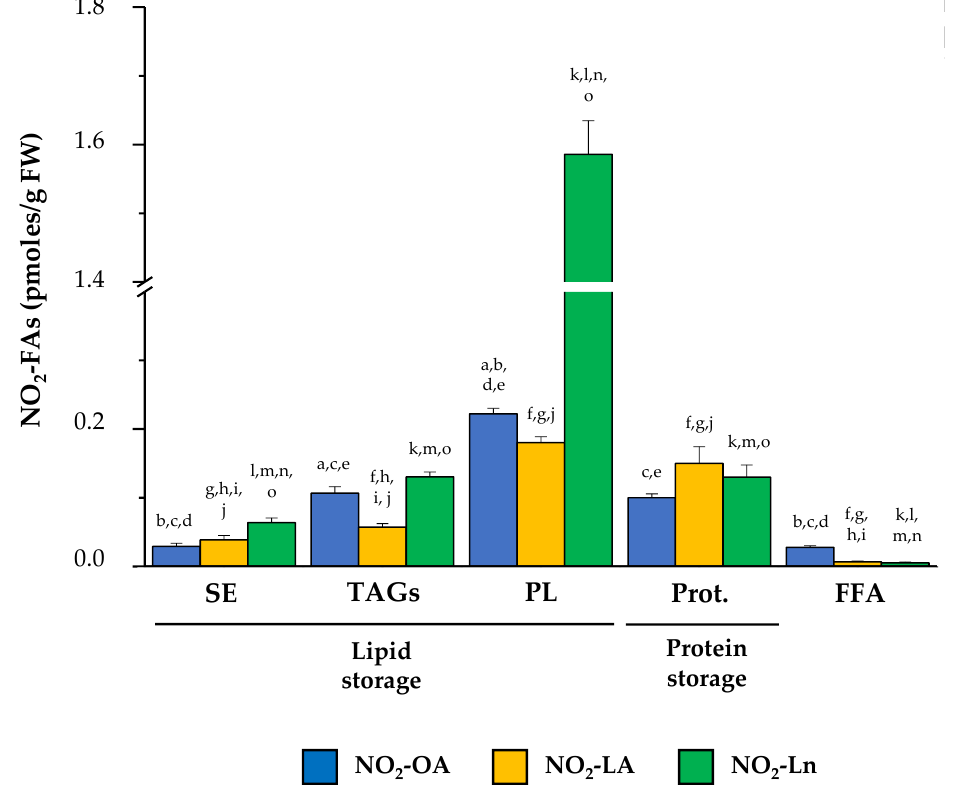
Figure 3. The main NO 2 -FAs storage biomolecules in Arabidopsis thaliana . This figure shows the different lipid and protein reservoirs of NO 2 -FAs in the 14-day-old Arabidopsis seedlings. The lipid deposit consisted of SE, TAGs (including MAGs-DAGs), and the four phospholipid types (PC, PE, PS, and PI). The protein deposit is represented by the NO 2 -FAs that were experimentally released from adducts with proteins. The FFA levels, which were neither esterified nor adducted, are also shown. The NO 2 -FAs values are the mean ± SEM of at least ten independent experiments. The sta- tistical significance between means was analyzed by the Student ’ s t -test. Letters a, b, c, d, and e indicate the significant differences ( p < 0.05) between the NO 2 -OA levels found in SE (a), TAGs (b), PL (c), Prot. (d), and FFA (e). Letters f, g, h, I, and j denote the significant differences ( p < 0.05) between the NO 2 -LA levels found in SE (f), TAGs (g), PL (h), Prot. (i), and FFA (j). Letters k, l, m, n, and o represent the significant differences ( p < 0.05) between the NO 2 -Ln levels found in SE (k), TAGs (l), PL (m), Prot. (n), and FFA (o). PL, phospholipids; Prot., proteins. 3.3. Endogenous Levels of NO 2 -FAs during Arabidopsis thaliana Development After identifying the endogenous presence of NO 2 -OA, NO 2 -LA, and NO 2 -Ln in Ara- bidopsis, the NO 2 -FAs levels were quantified in different plant developmental stages. Figure 4 shows the endogenous levels of the NO 2 -FAs esterified with complex lipids (panel A), those which came from the adduction with proteins (panel B), and the total levels when considering both protein and lipid storages (panel C) in each plant development stage.